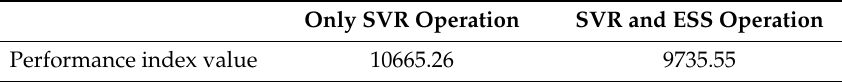
Figure 25. Comparison of the performance index for simulation results. Table 4. Comparison of the performance index of each